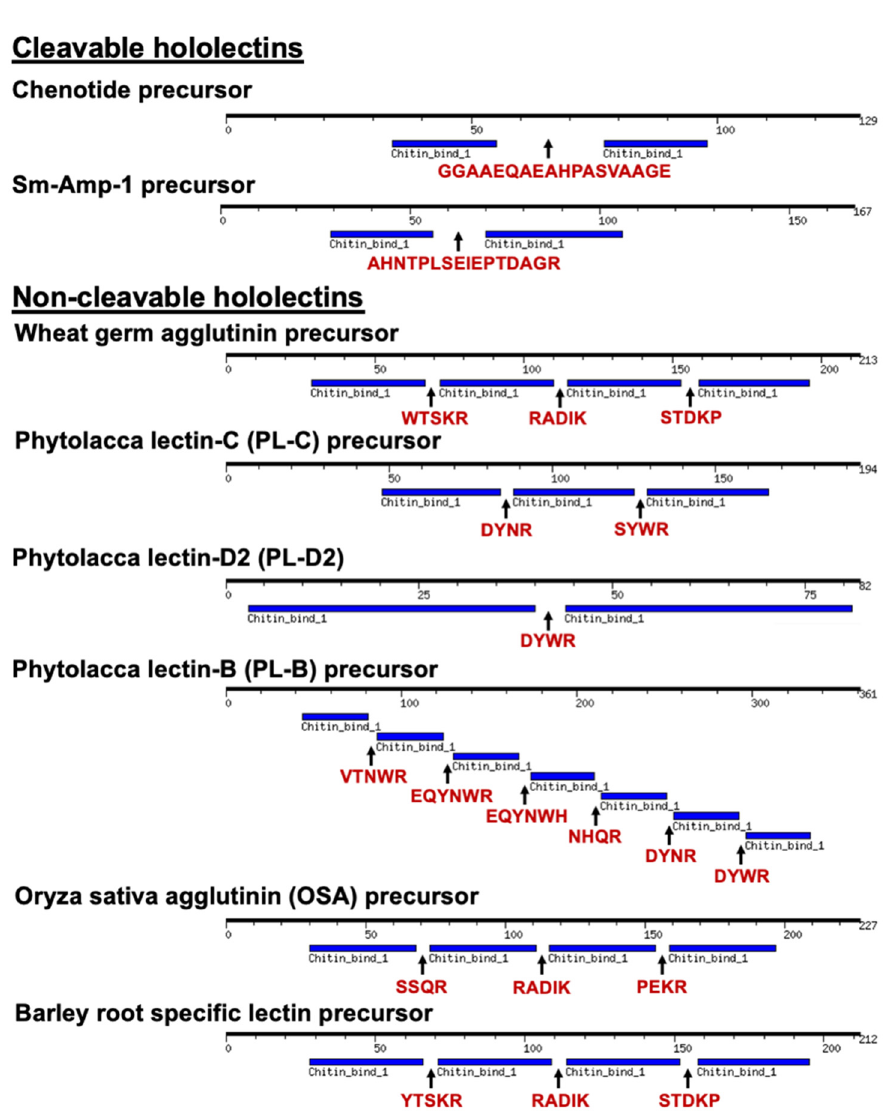
Figure 9. Precursor architecture of cleavable hololectins (including chenotide, and Sm-Amp-1: UniProtKB-E1UYT9) and non-cleavable hololectins (including wheat germ agglutinin (WGA: UniProtKB-P02876), phytolacca lectin-C (PL-C: UniProtKB-Q9AYP9), phytolacca lectin-D2 (PL-D2: UniProtKB-P83790), phytolacca lectin-B (PL-B: UniProtKB-Q9AVB0), Oryza sativa agglutinin (OSA: UniProtKB-Q0JF21), and barley root-specific lectin: UniProtKB-P15312). The amino acid sequences of hinge regions are colored in red. Chitin-binding hevein-like peptide domains are colored in blue. The hinge regions of non-cleavable hololectins are 4–6 amino acid residues in length, whereas the hinge region of chenotide and Sm-Amp-1 precursors are 18 and 16 amino acid residues long, respectively.